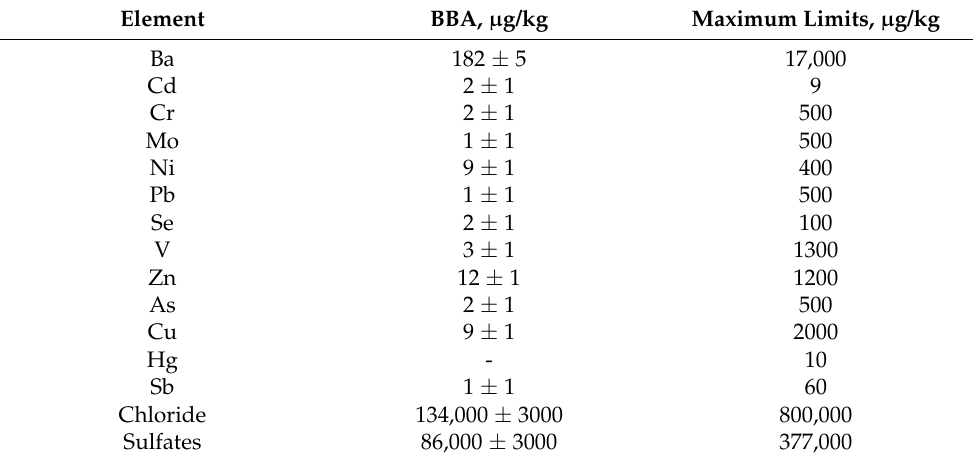
Table 6. Concentration of chemical elements in biomass bottom ash leachate compared to regulatory limits, UNE-EN 12457-3 standard.